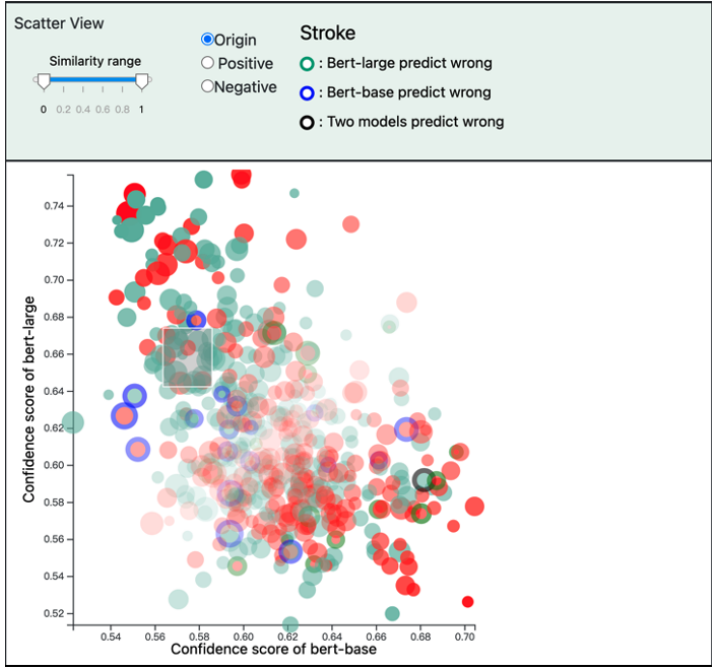
Figure 9. Scatter view. This view helps users find interesting instances through confidence score, ground truth label, and prediction correctness of models. Green and red color circles indicate positive and negative emotion instances, respectively. Users can filter and select these instances in this